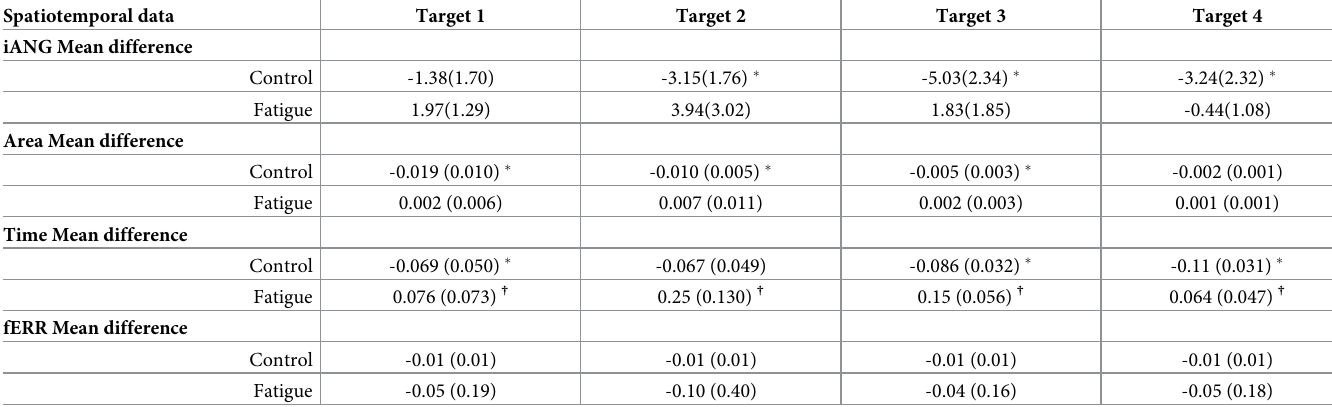
Table 4. Spatiotemporal data mean difference between baseline and experimental condition of both